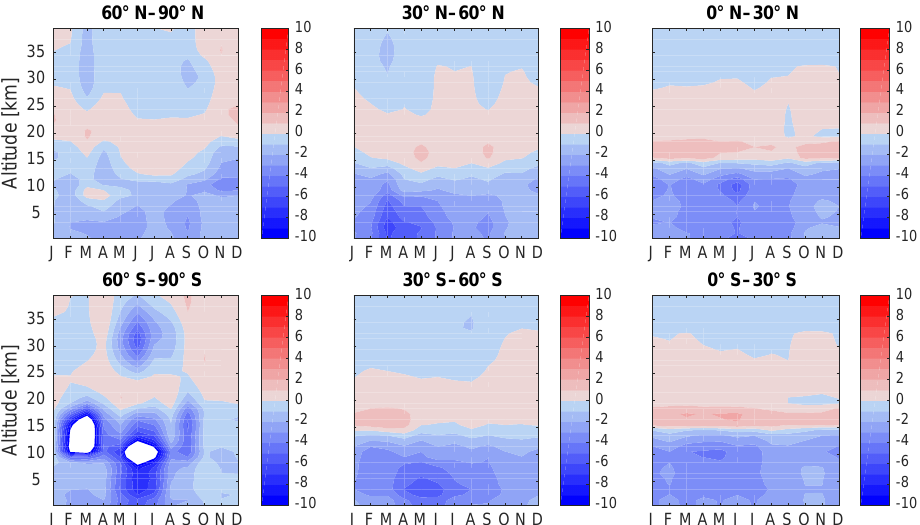
Figure 4. Contour representation of the relative difference (in percent) between IASI-A and IASI-B ozone concentrations as a function of altitude and time for the year 2014 for daytime data. The relative differences are calculated as 100 × (IASI-A − IASI-B) / IASI-A. The white area located in the southern high latitudes corresponds to differences ranging between − 20 and −